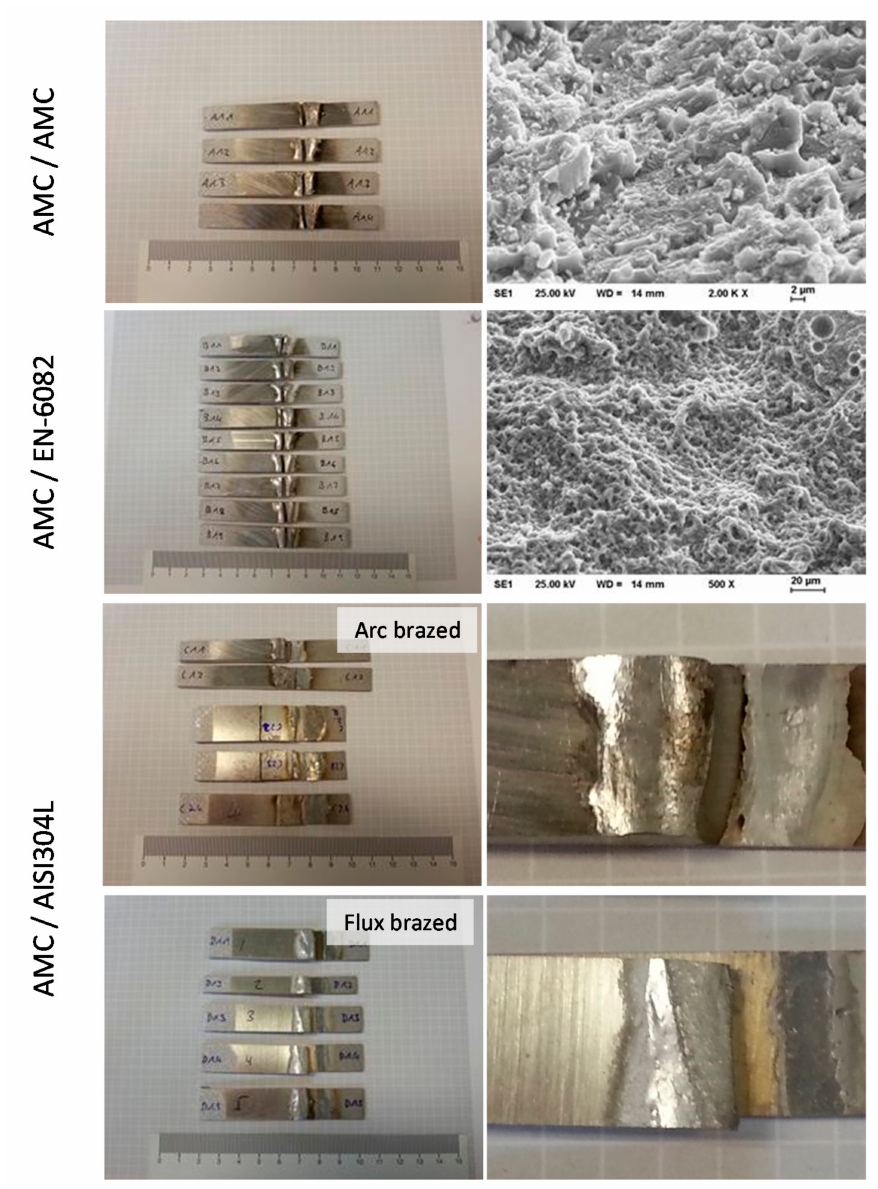
Figure 8. Tested specimens and resulting areas of fracture in accordance to the test and bond strength values presented in Figure